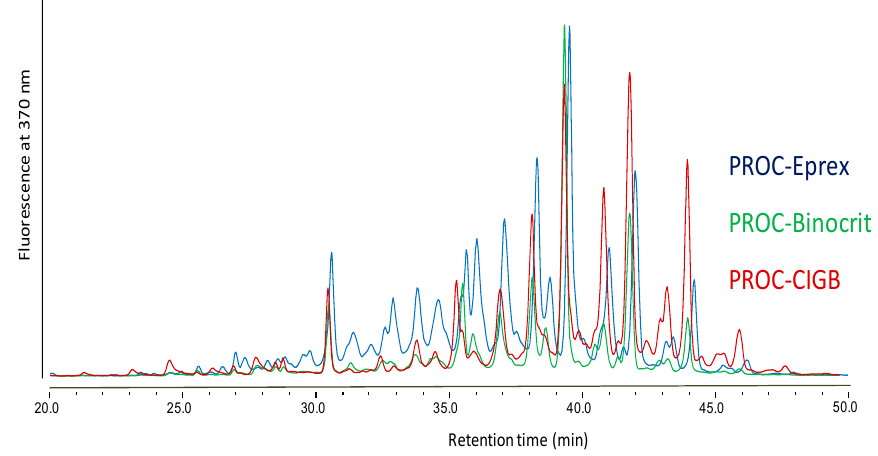
Figure 1. Liquid chromatography (LC) analysis of procainamide (PROC) labelled N -glycans contained in Eprex, Binocrit and CIGB-EPO.